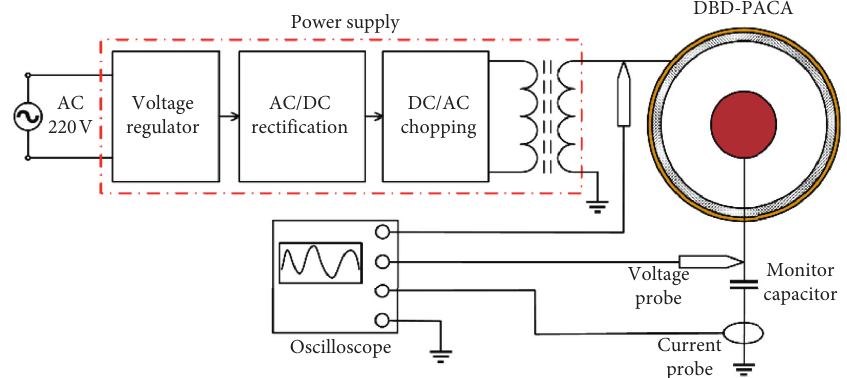
Figure 2: Electrical circuit diagrams of the